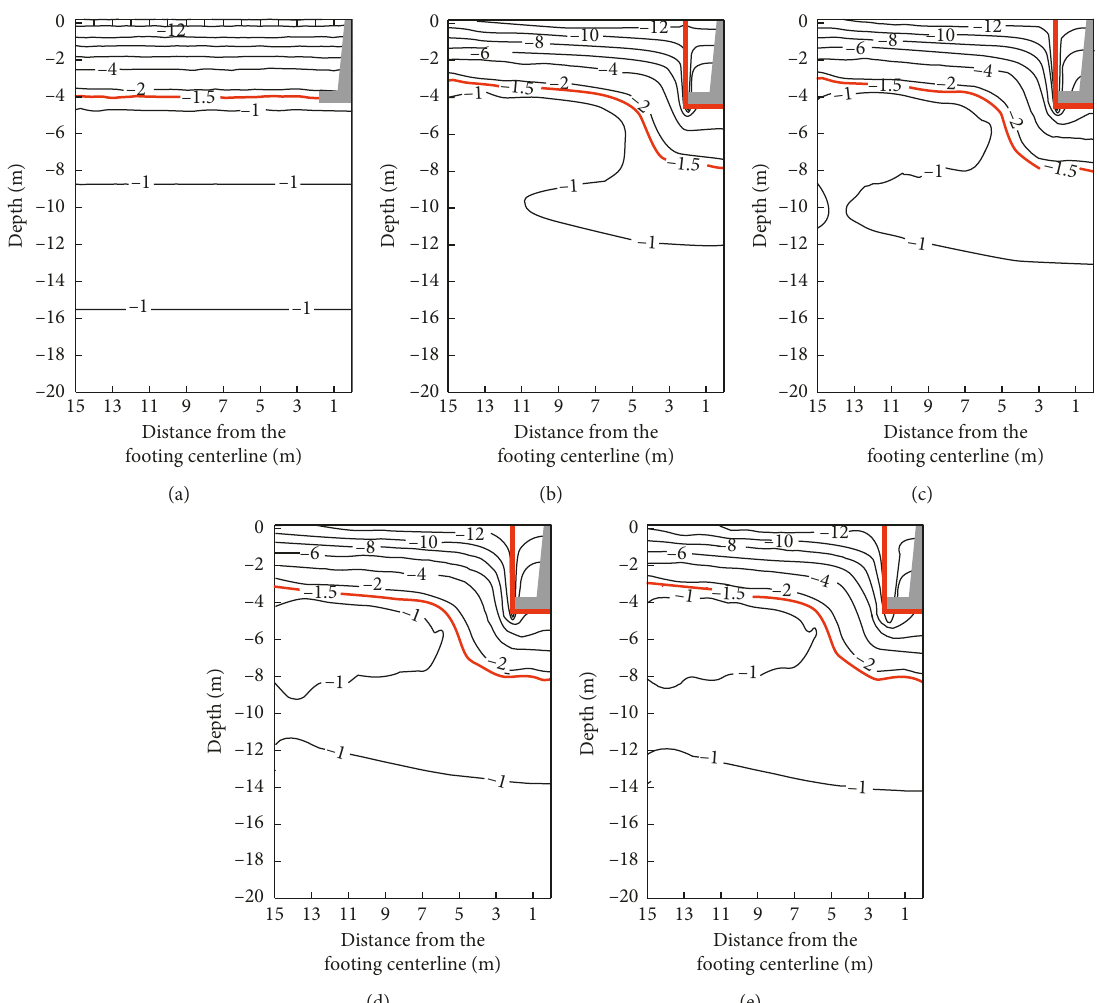
Figure 5: Temperature distributions of the duct-ventilated tower foundation on January 15 with different diameters. (a) No ventilation duct. (b) D � 8 cm. (c) D � 12cm. (d) D � 16cm. (e) D � 20